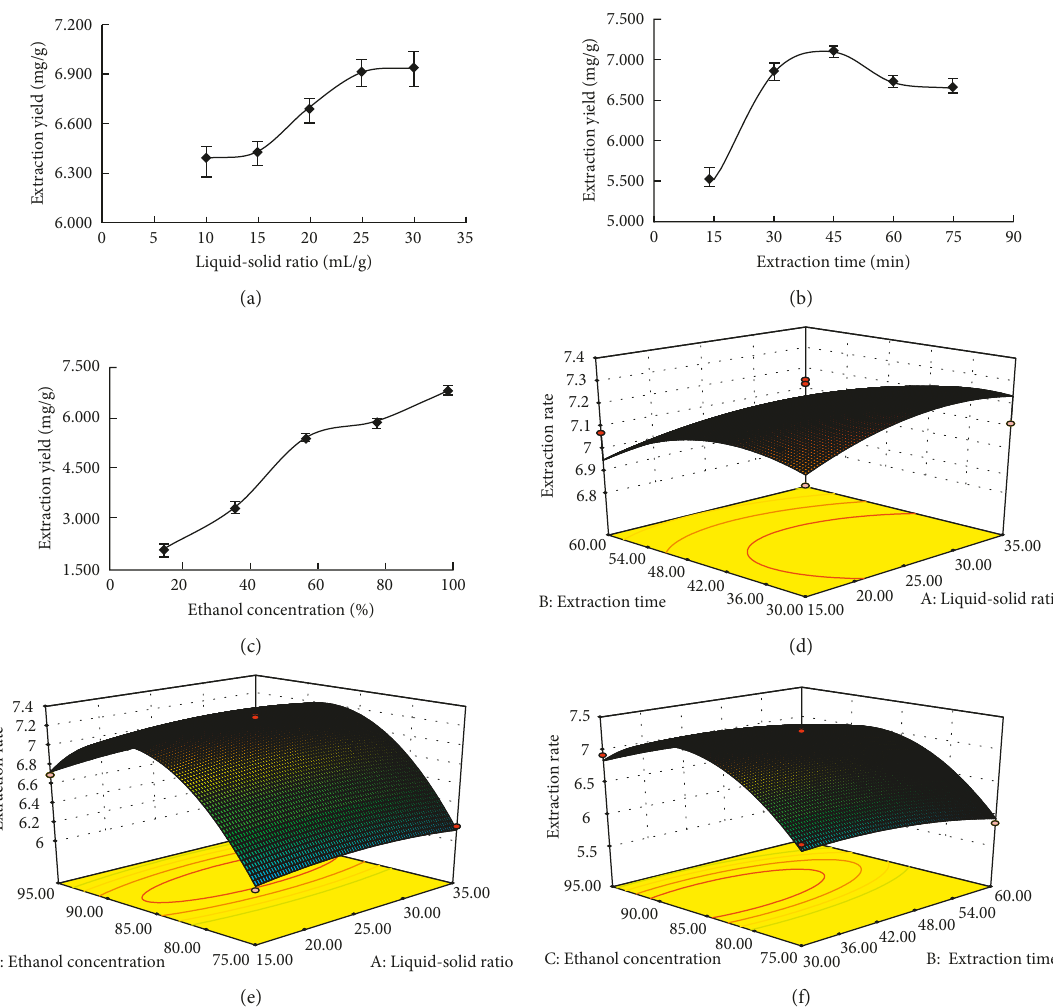
Figure 2: Effects of independent parameters: liquid-solid ratio (a), extraction time (b), and ethanol concentration (c) on the extraction yield of triterpenoids. Interaction effects between the liquid-solid ratio and extraction time (d), liquid-solid ratio and ethanol concentration (e), and extraction time and ethanol concentration (f) on the yield of